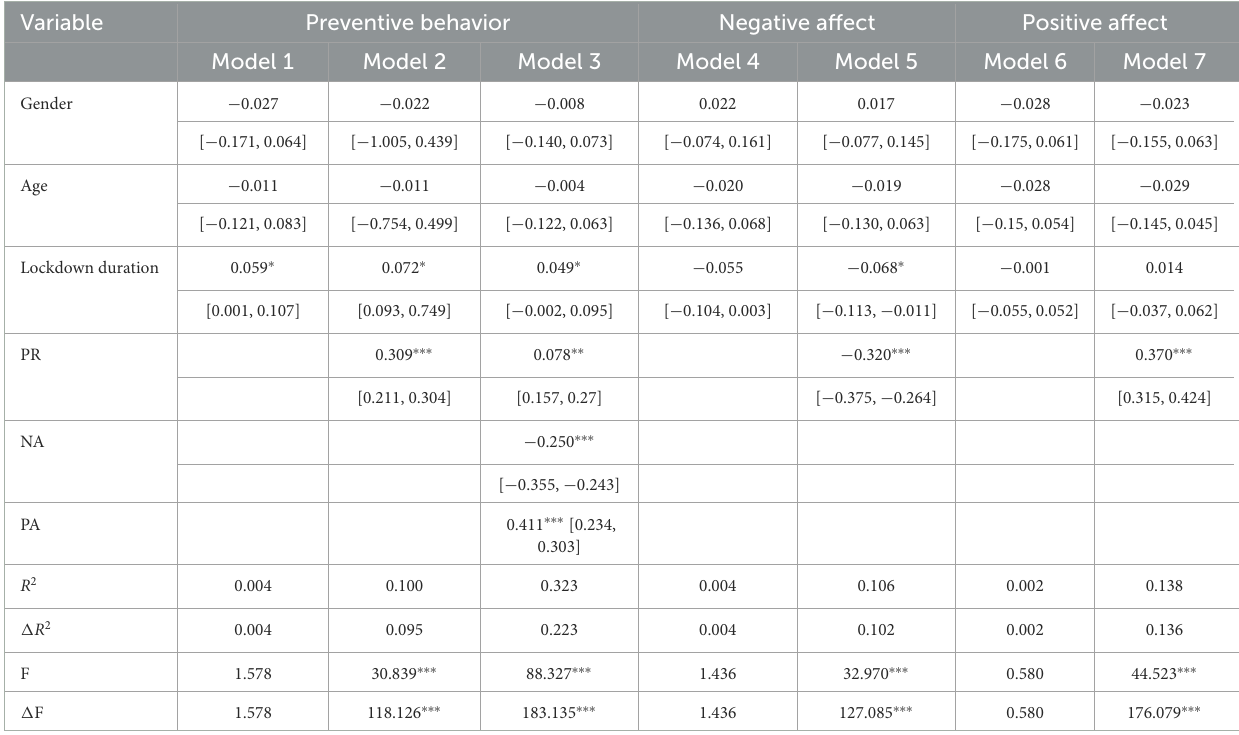
TABLE 3 Hierarchical linear regression